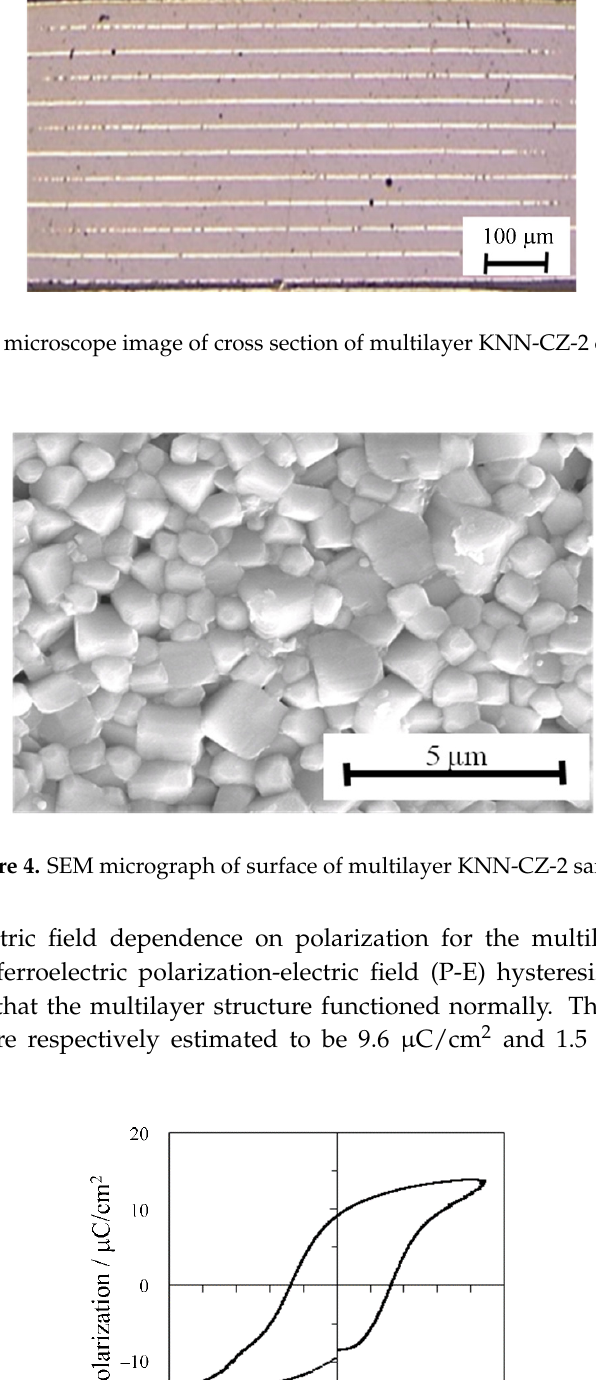
Figure 5. P ‐ E hysteresis curve for multilayer KNN ‐ CZ ‐ 2 sample.